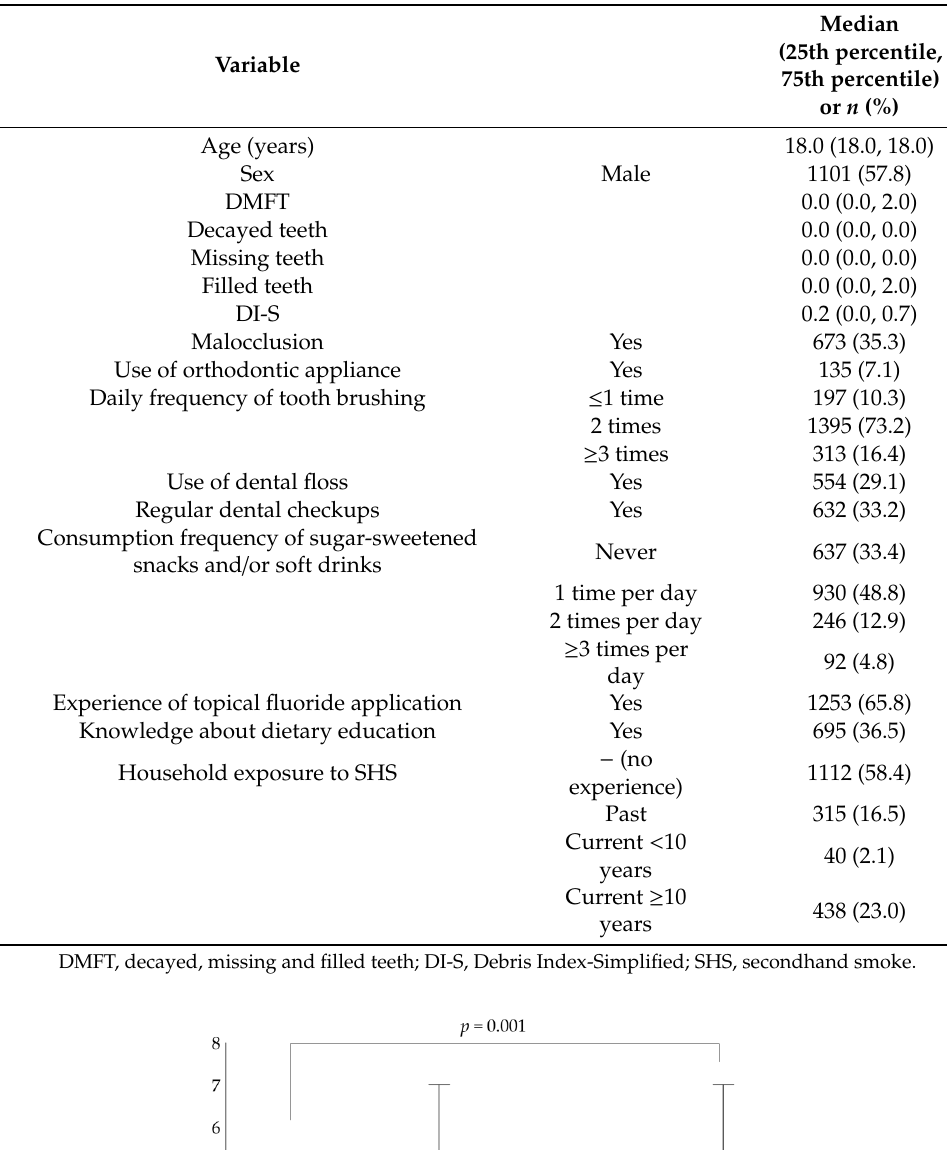
Table 2. Differences in variables between DMFT = 0 and DMFT ≥ 1 groups.